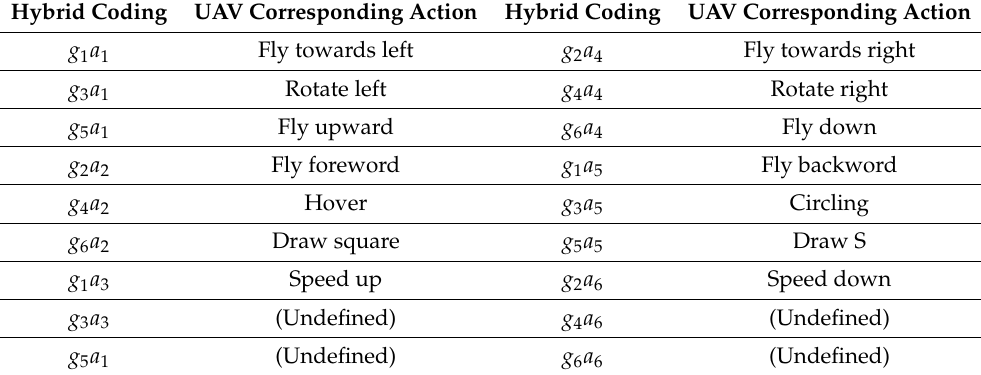
Figure 16. Sparse coding of Gestures-Action combinations. (The orange blocks are selected into our codebook). Table 2. UAV flight action obtained through the cross validation